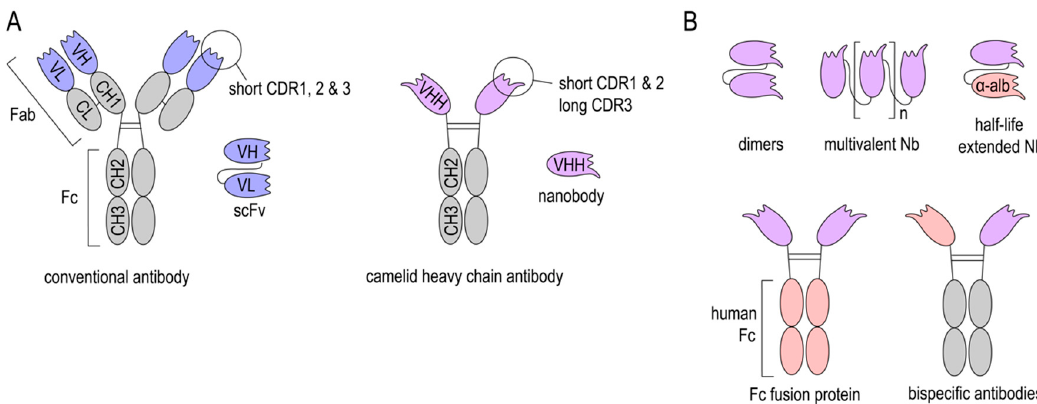
Figure 1. Structure of Nanobodies. ( A ) Structure of conventional antibodies (cAb), single-chain variable fragments (scFv), heavy-chain antibody (HcAb), and Nanobodies (Nbs). ( B ) Nbs can be produced as dimers and multimers to improve binding to their target or linked to an anti-albumin Nb to increase their in vivo half-life. Latter can be also achieved by fusing an Fc region of e.g., human IgG. Further, bispecific Nb-Fc-fusion proteins can also be expressed.